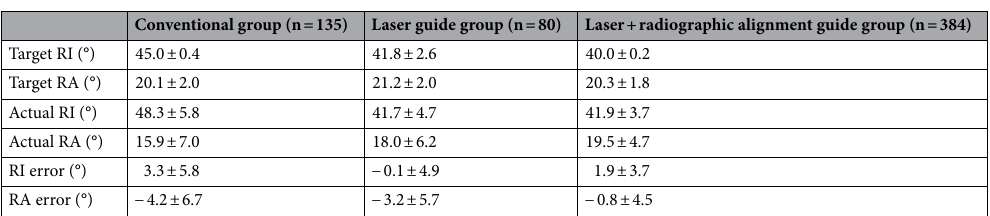
Table 1. Target, actual, and error angles of RI and RA. Values are expressed as mean with standard deviation. RI radiographic inclination, RA radiographic